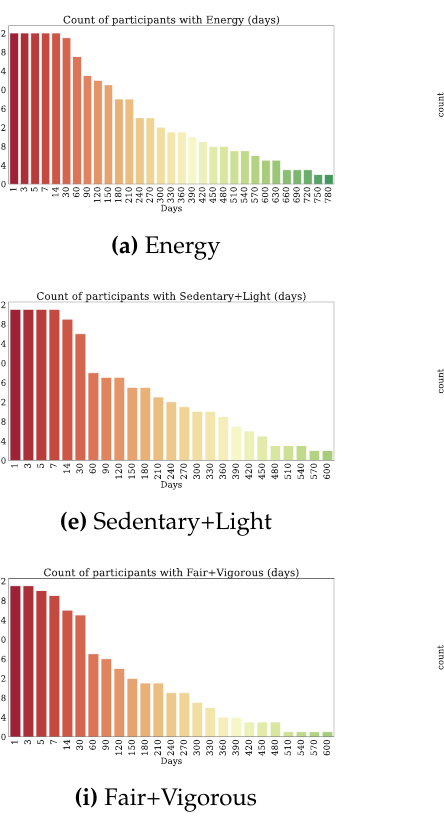
Figure A12. Count of seniors with at least the given valid days of Fitbit (TechRO) by outcome